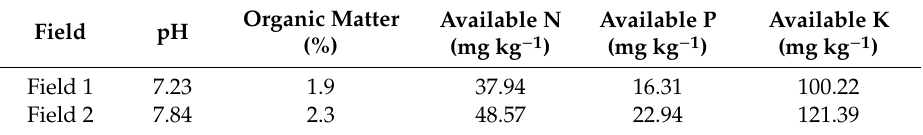
Table 1. Initial soil properties along the root zone profile in the top 20-cm